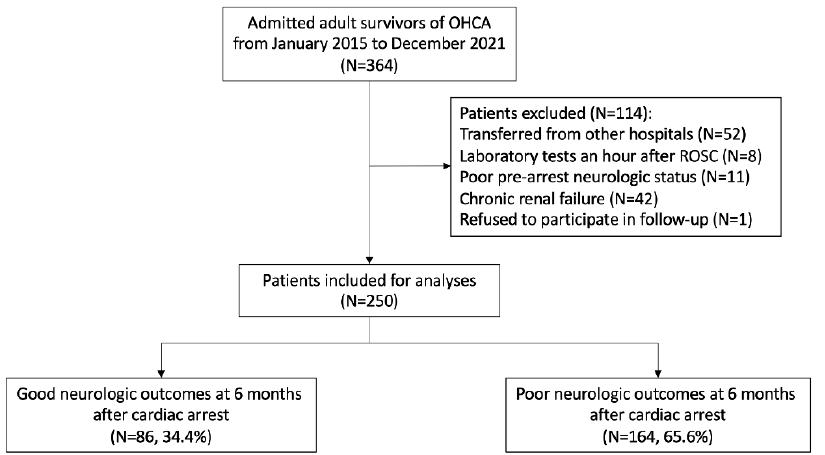
Figure 1. Flow diagram for the enrolment of the patients in the study. Abbreviations: OHCA, out-of-hospital cardiac arrest; ROSC, return of spontaneous circulation.